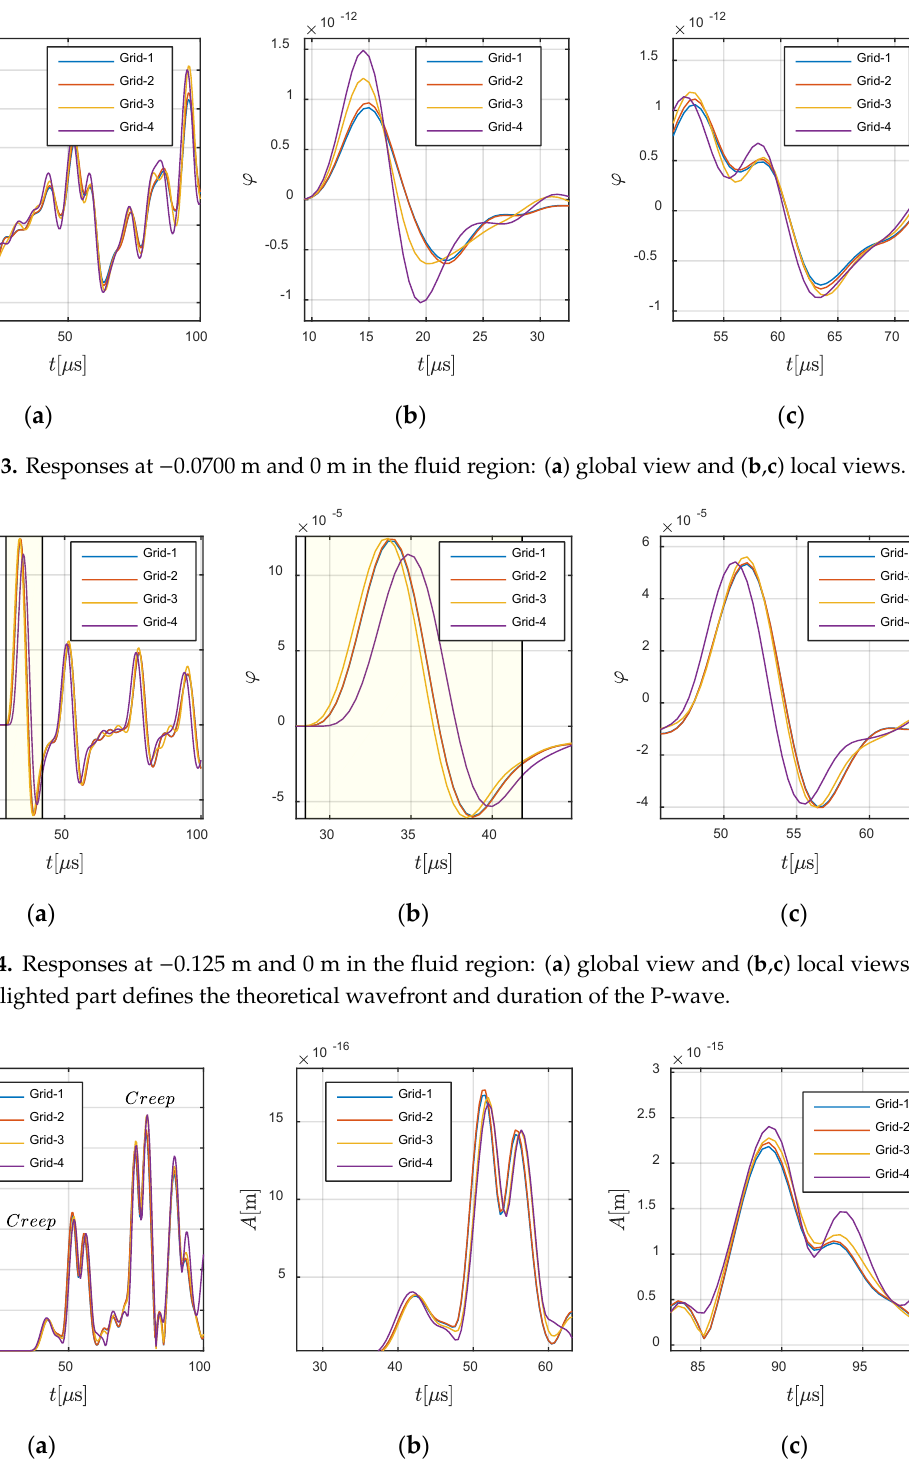
( c ) Figure 11. Responses in X- direction at − 0.0625 m and 0 m in the solid region: ( a ) global view and ( b , c ) local views. The highlighted part defines the theoretical wavefront and duration of the P-wave.